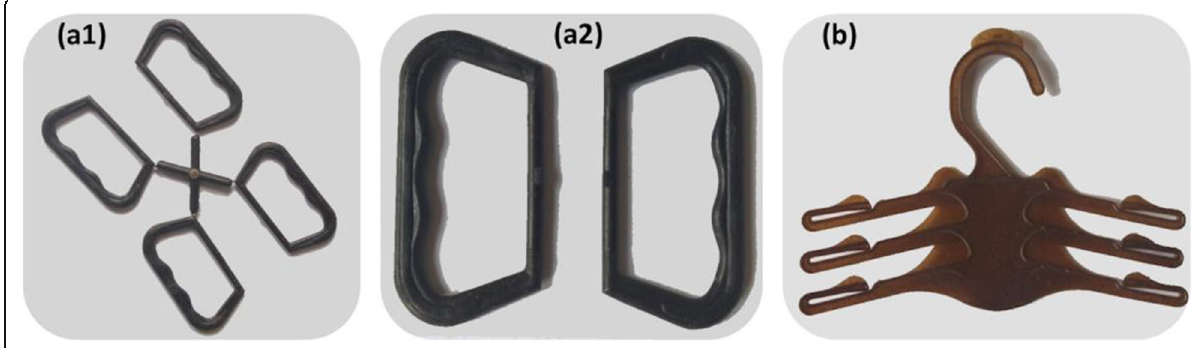
Fig. 9 Injection molded products: bag handles (a1, a2) and clothes hanger (b)